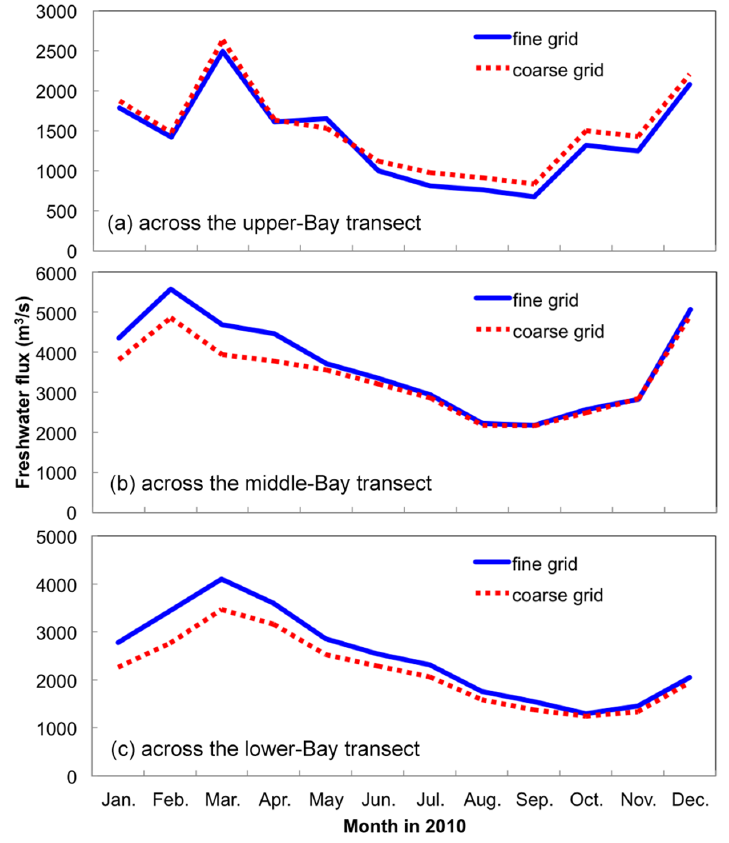
Figure 5. Freshwater transport across the ( a ) upper-, ( b ) middle-, and ( c ) lower-Bay transects (Figure 1) in the fine ‐ gird (blue solid line) and coarse ‐ grid (red dash line) models.